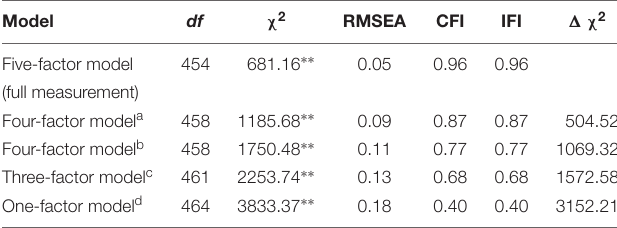
TABLE 2 | Measurement model comparisons.